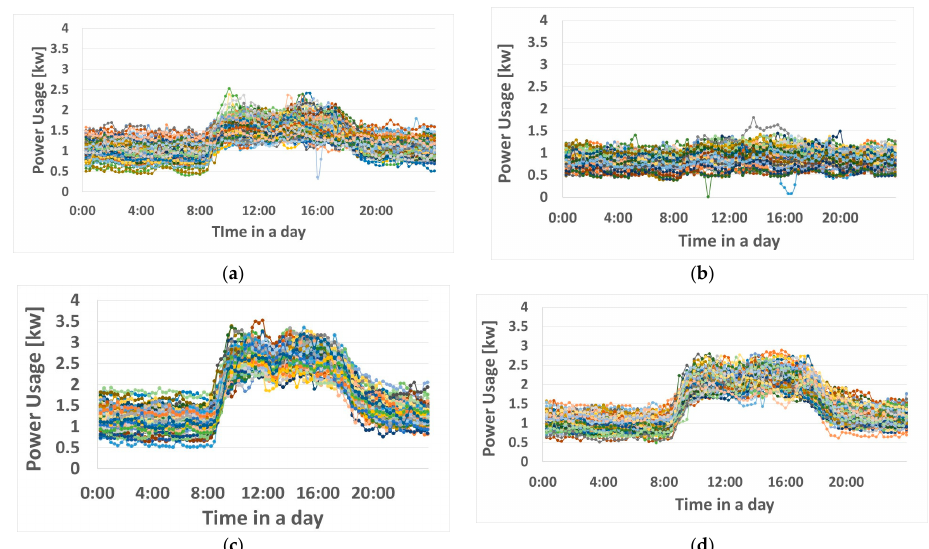
Figure 10. Classified day loads of one building in 2013, Korea. ( a ) Group1, ( b ) Group2, ( c ) Group3 and ( d ) Group4 were generated by k-means clustering with k = 4 which provided the best accuracy for predicting the load data of 2014 for the same building.